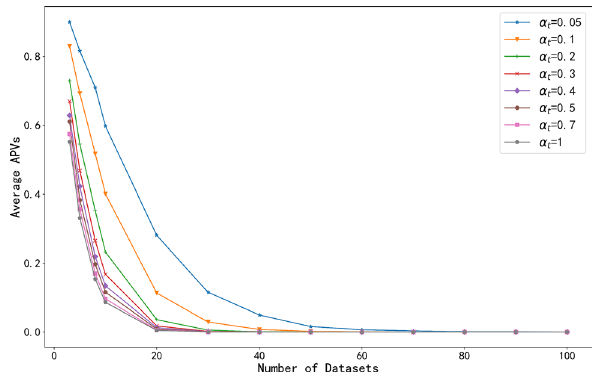
Fig. 13 Average APVs of t-Friedman test with different significance level of t test under the experiment setting x, the number of algo- rithms K =